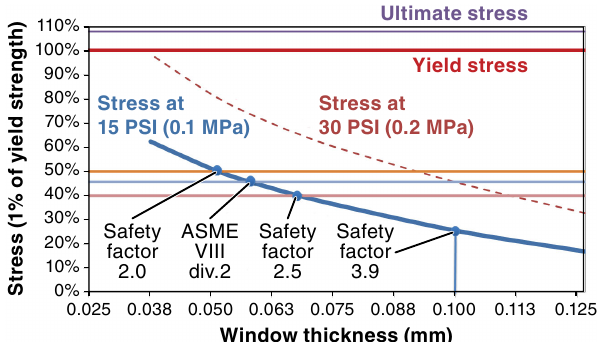
FIG. 10. Horizontal and vertical beam separation scan obtained by steering the 5 keV electron beam with respect to the 100 GeV = nucleon gold